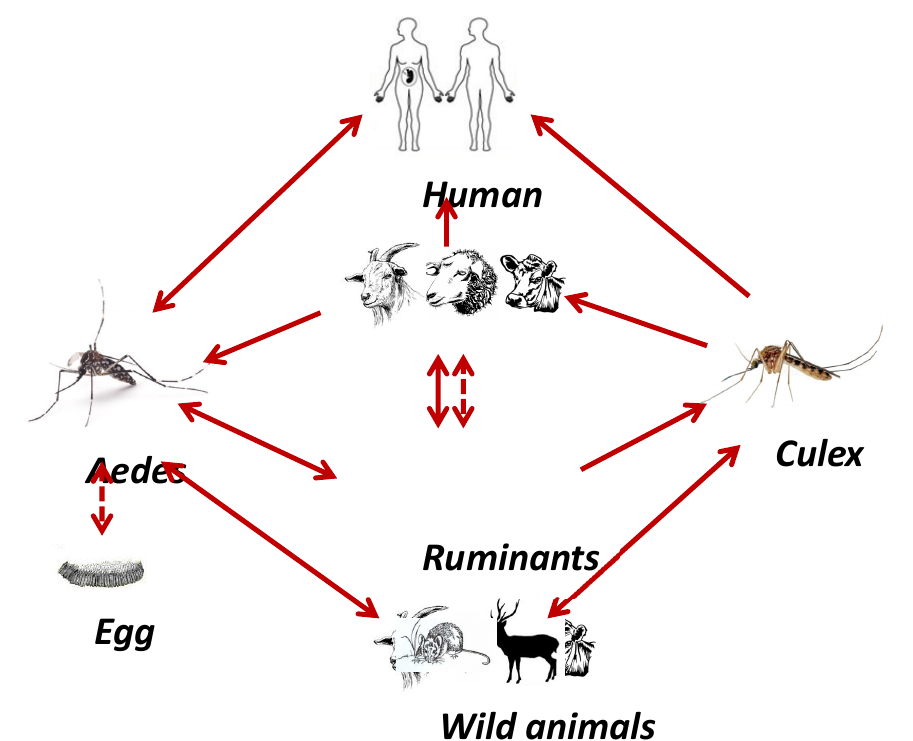
Figure 2. The life cycle of the RVF virus in Egypt and the role of the mosquito vectors. There are two transmission cycles for RVFV in nature: (1) an enzootic cycle that can occur during the normal rainfall and involves the Aedes mosquitoes, which transmit the virus vertically to their offsprings, and (2) an epidemic-epizootic cycle that occurs during abnormally heavy rainfall and flooding of dams or during the warm season. The virus is transmitted transovarially and the Culex mosquitoes distribute the virus and induce the emergence of outbreaks. The transmission of the virus to humans occurs by direct contact with infected animals. The continuous line represents the direct transmission, while the dashed line represents the vertical transmission.